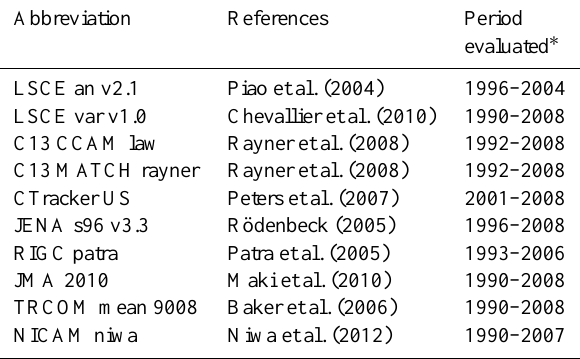
Table 3. List of atmospheric CO 2 inversions included in this study.